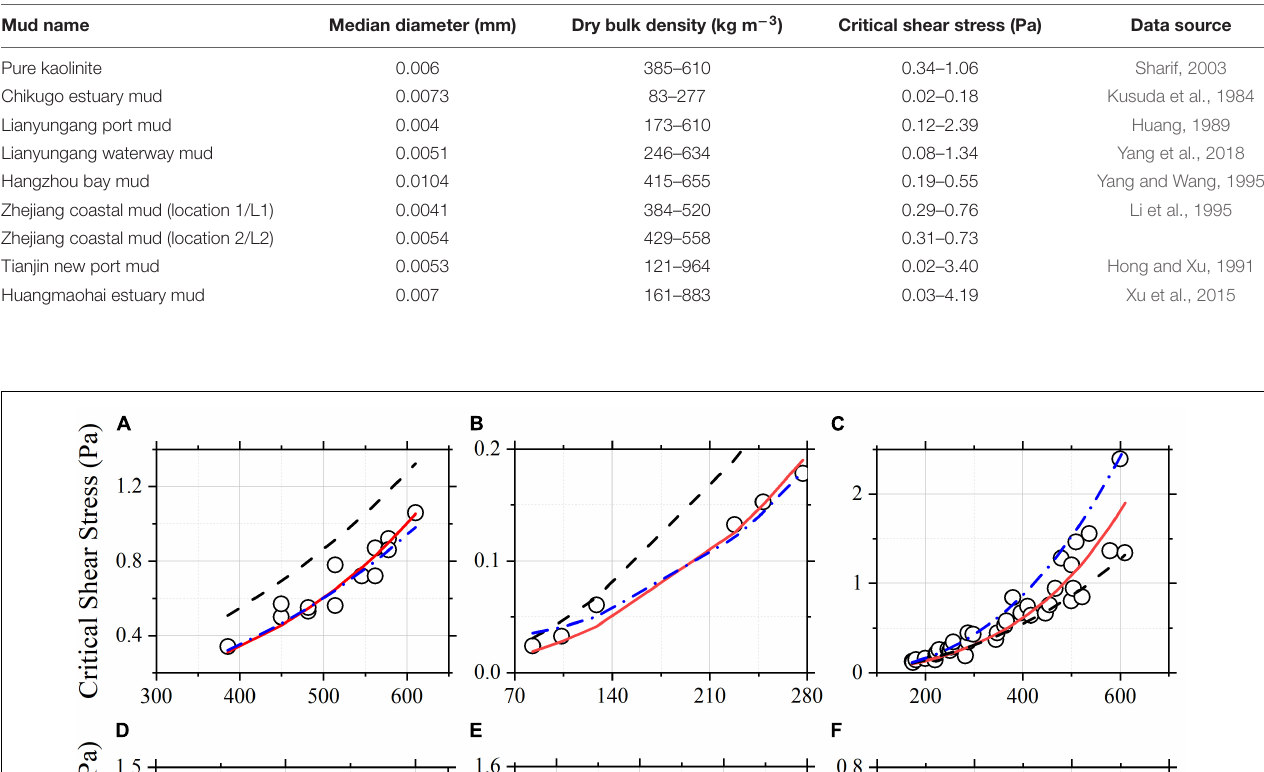
TABLE 2 | Summary of collected experimental data of pure mud and data sources.